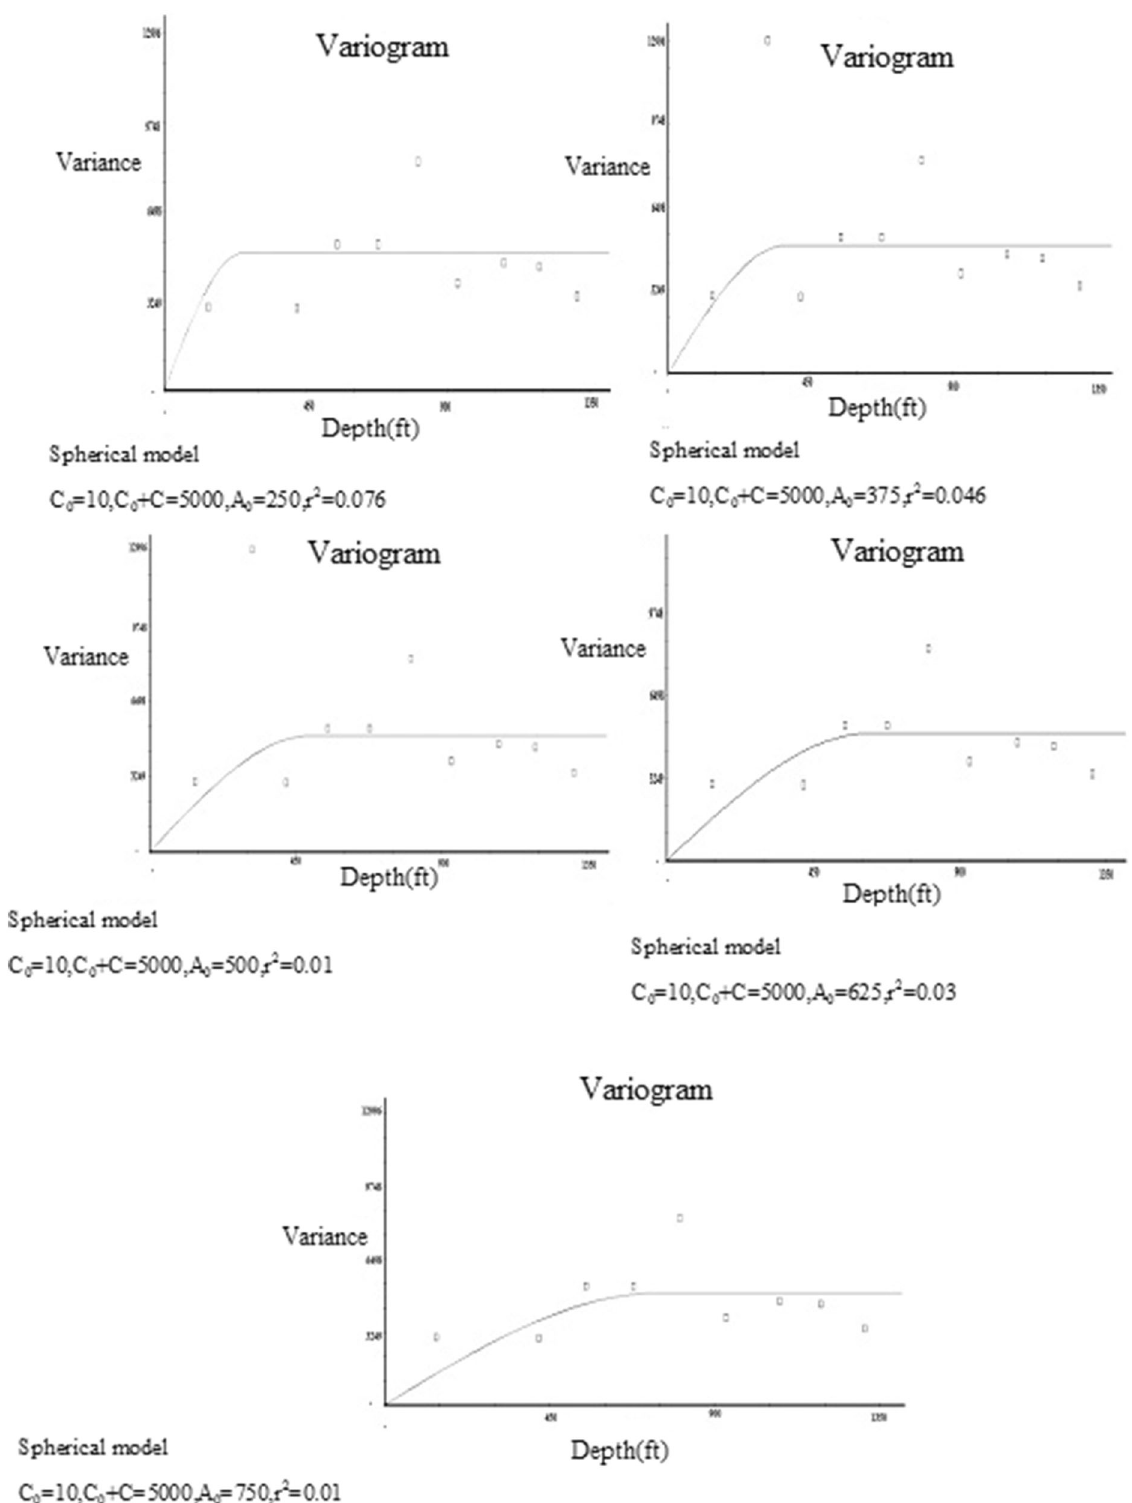
Fig. 1 Variogram models for different